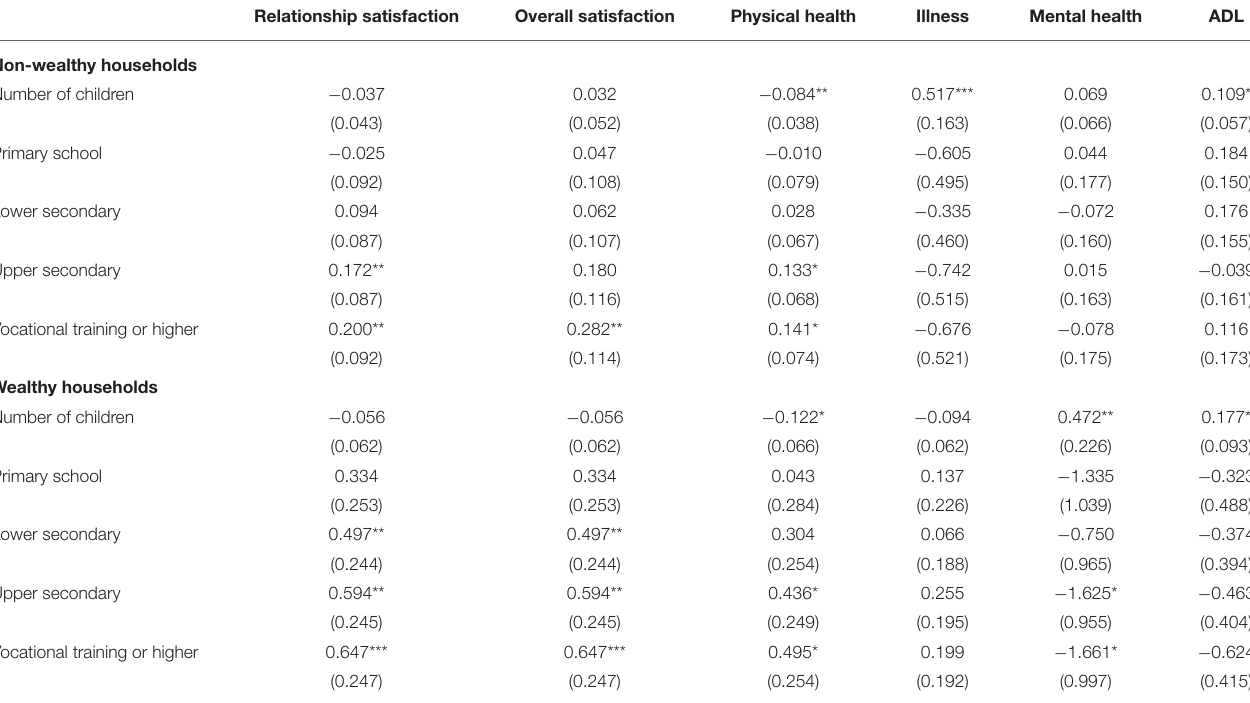
TABLE 4 | Impacts on parental health and well-being in non-wealthy and wealthy households (IV